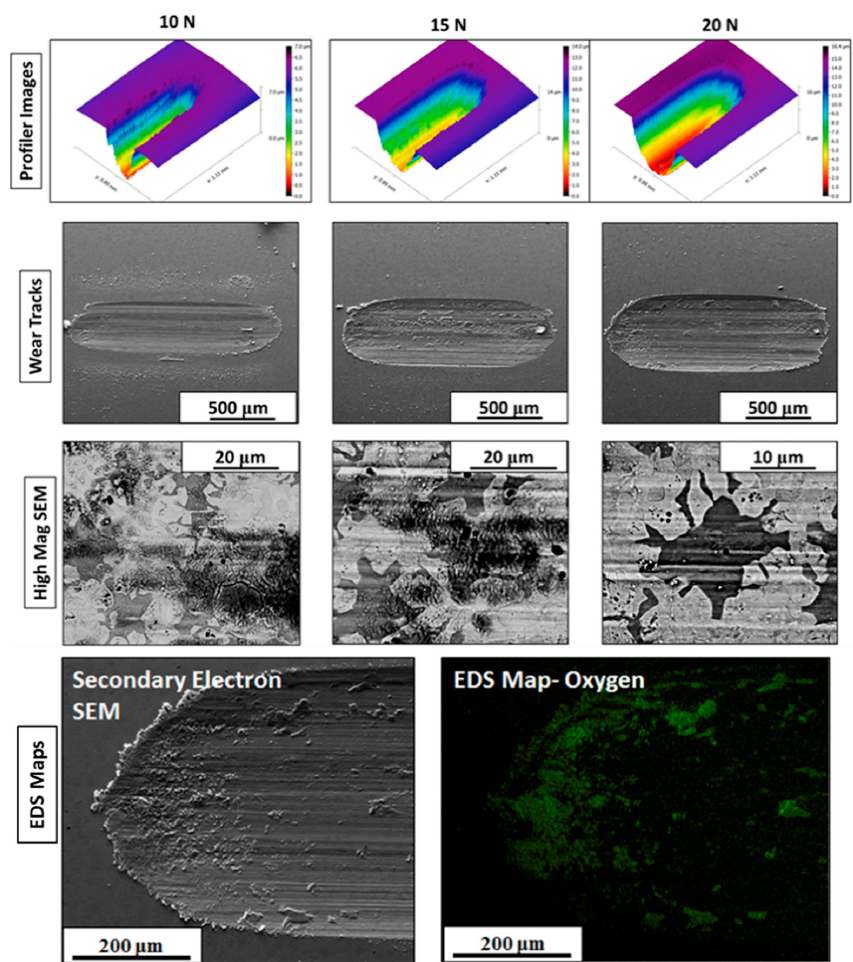
Figure 30. Wear behavior of Al 0.2 Co 1.5 CrFeNi 1.5 Ti 1.0 alloy. The alloy showed increased wear